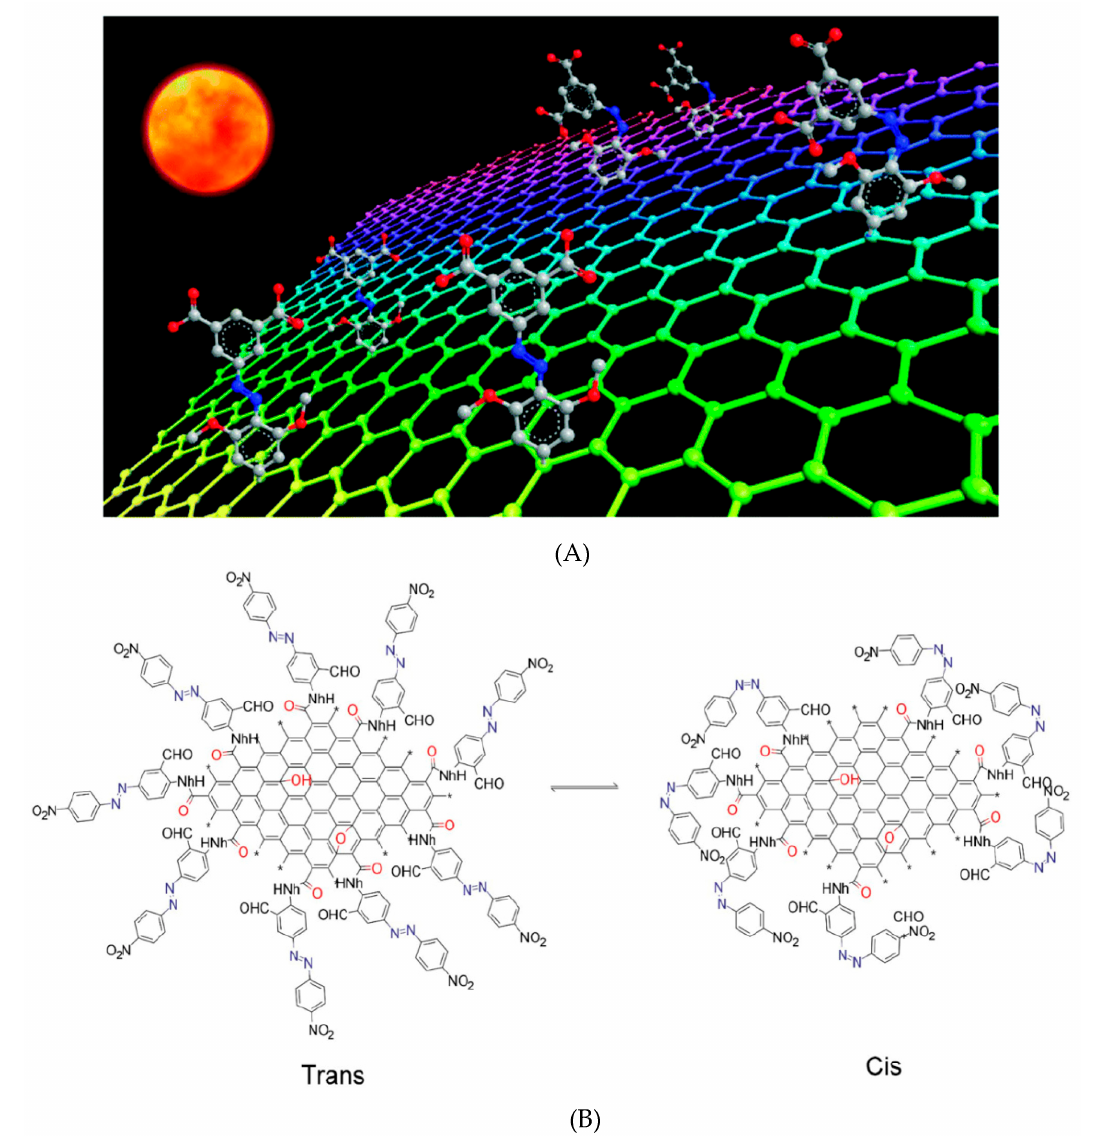
Figure 12. ( A ) Photo-induced isomerization-based AZO-RGO solar thermal storage material: